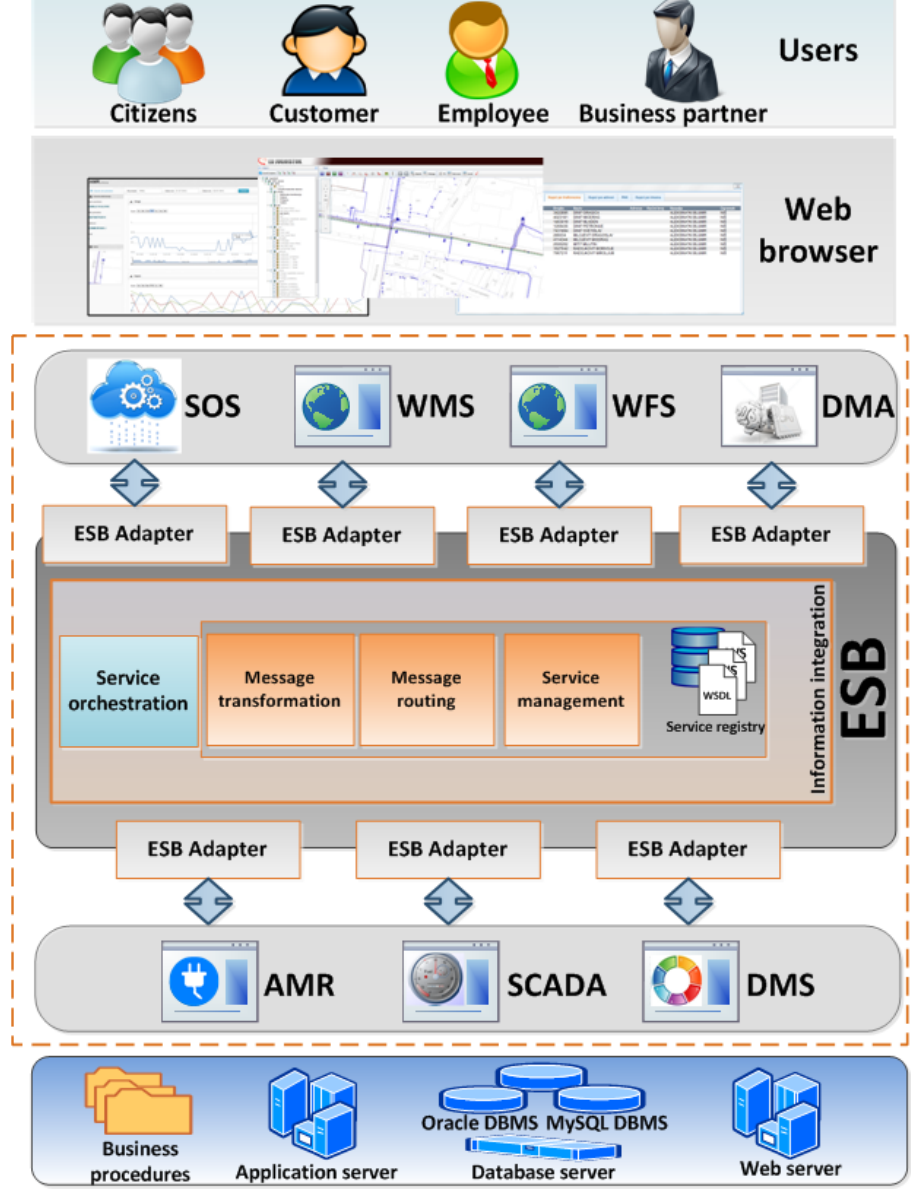
Figure 2. Service-oriented integration solution with ESB integration